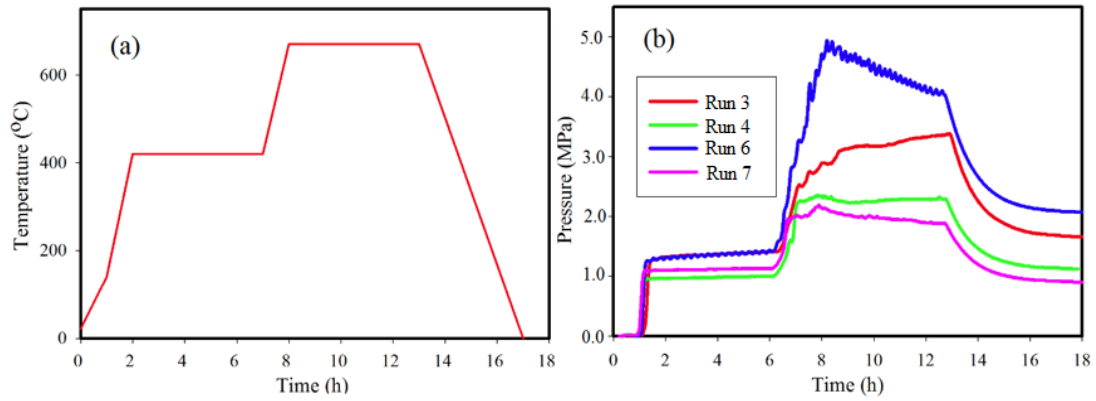
Figure 2. ( a ) Heating profile and ( b ) pressure profile for synthesis of Ni-B phases for Run 3, Run 4, Run 6, and Run 7 with conditions as listed in Table 1.